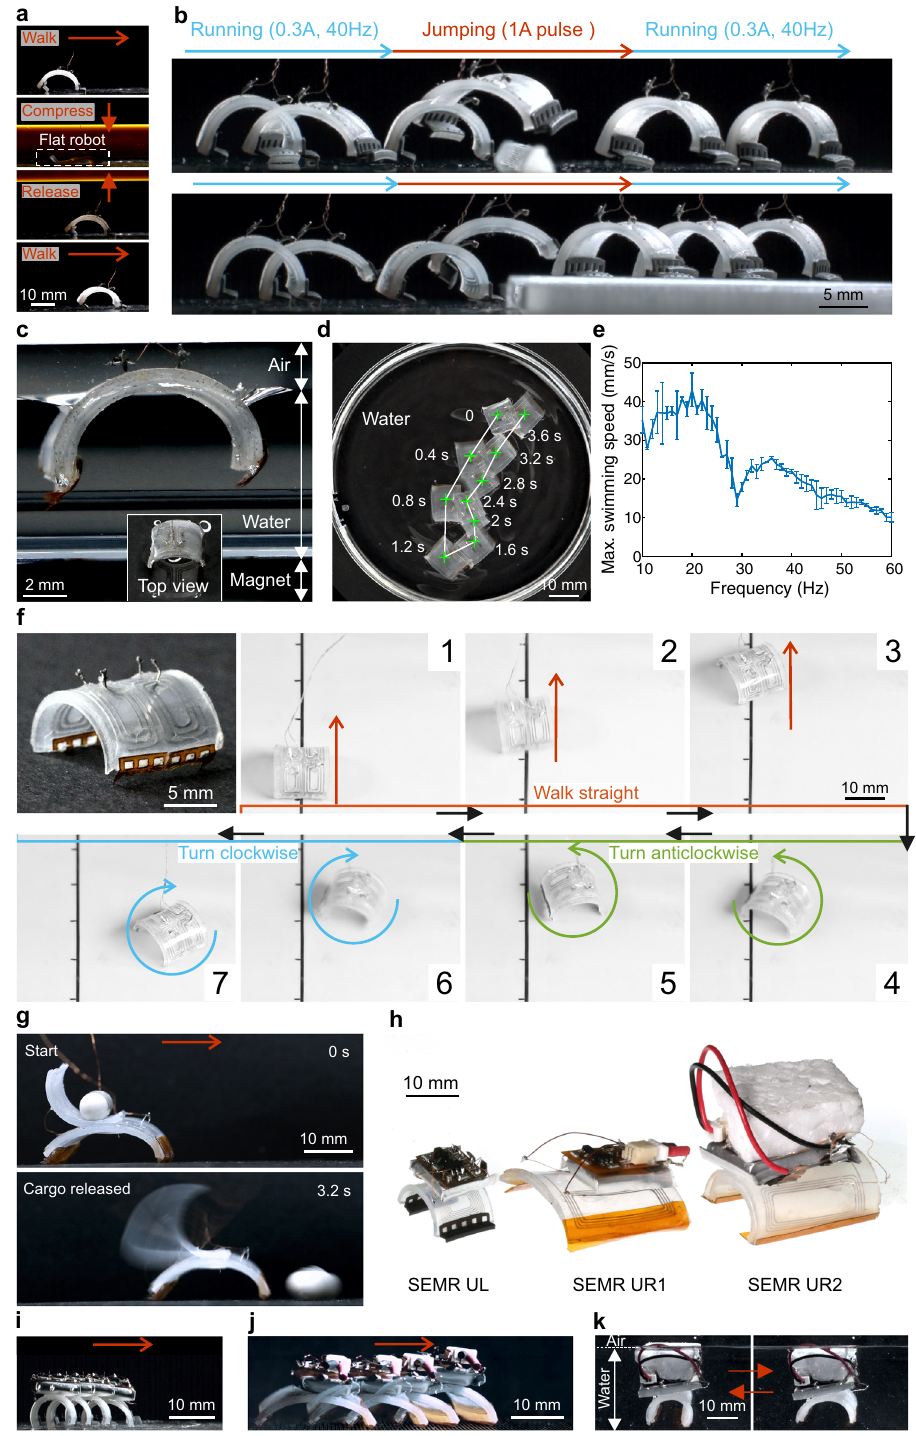
Fig. 4 | Robust and versatile SEMRs: jumping, swimming, navigating and autonomy. a Robustness test showing the resilience of SEMR TL upon external loading (Supplementary Movie 5). The robot resumes walking after being pressed and fully fl attened twice (driving current, 0.3A, 1Hz). b The SEMR jumps across (top one) and onto (bottom one) a 2.5-mm-high object (Supplementary Movie 6). c SEMRTST fl oatingonthesurfaceofthewater.Inset,topviewoftherobot. d Path of the swimming SEMR TST (Supplementary Movie 7). e Maximum swimming speed versus frequency for a driving current of 0.5A. Error bars represent the standard deviation of four measurements. f Two-module steerable SEMR TSTS. Frames 1 to 7 show straight walking, anticlockwise, and clockwise turns using